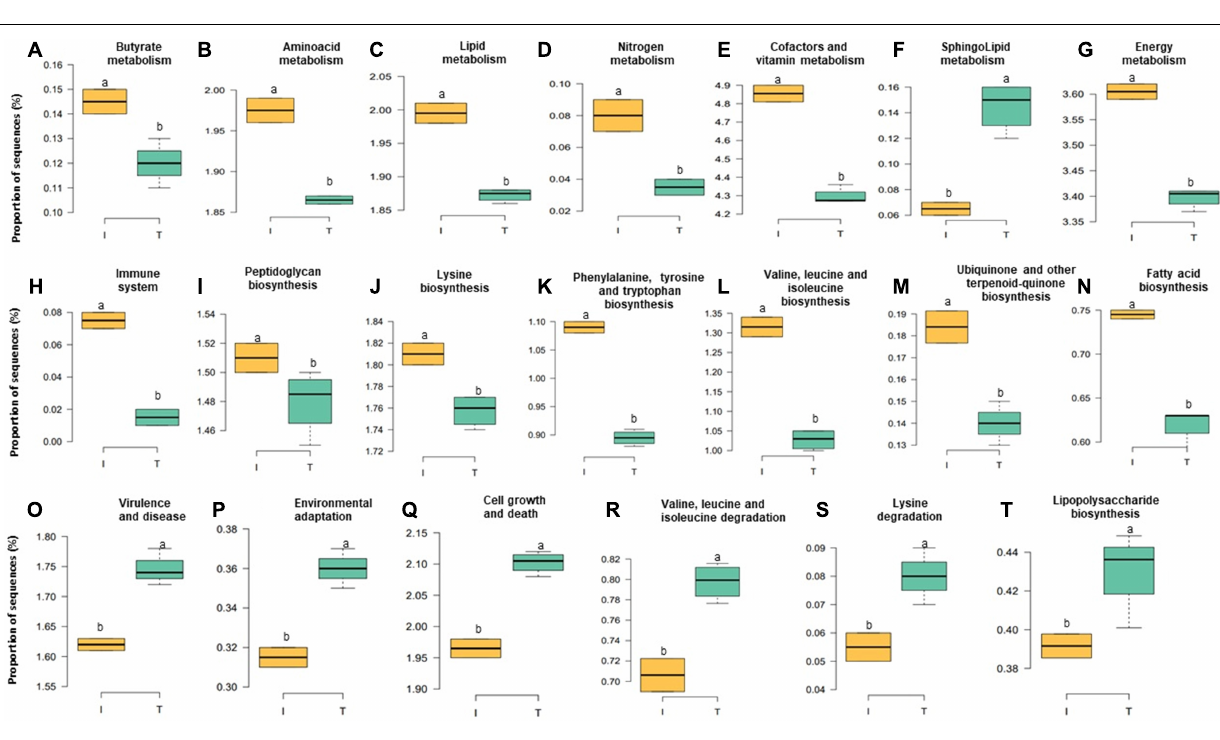
Frontiers in Microbiology |